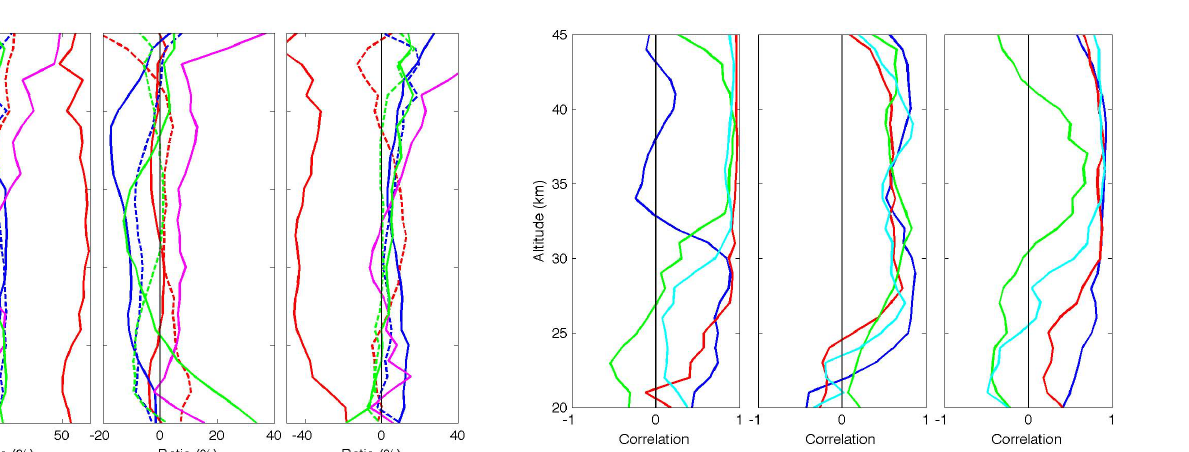
Fig. 27. NO 3 fitting components as a function of altitude in three latitude belts in the stratosphere. All amplitudes have been given as a ratio between the original amplitude in Eq. (2) and the the con- stant term c(z) in Eq. (2) and given in %. Line identifications: An- nual ( a 1 and b 1 ): solid and dashed red, respectively, Semi-annual ( a 2 and b 2 ): solid and dashed blue, respectively, QBO 10hPa ( q 1 ) and 30hPa ( q 2 ): solid and dashed green, respectively, solar ( s ): solid magenta. The zero value line has been shown by a thin black line. Left: 50 ◦ S–40 ◦ S, Middle: 10 ◦ S–10 ◦ N, Right: 40 ◦ N–50 ◦ N. Note that the x-axis ranges vary in panels.